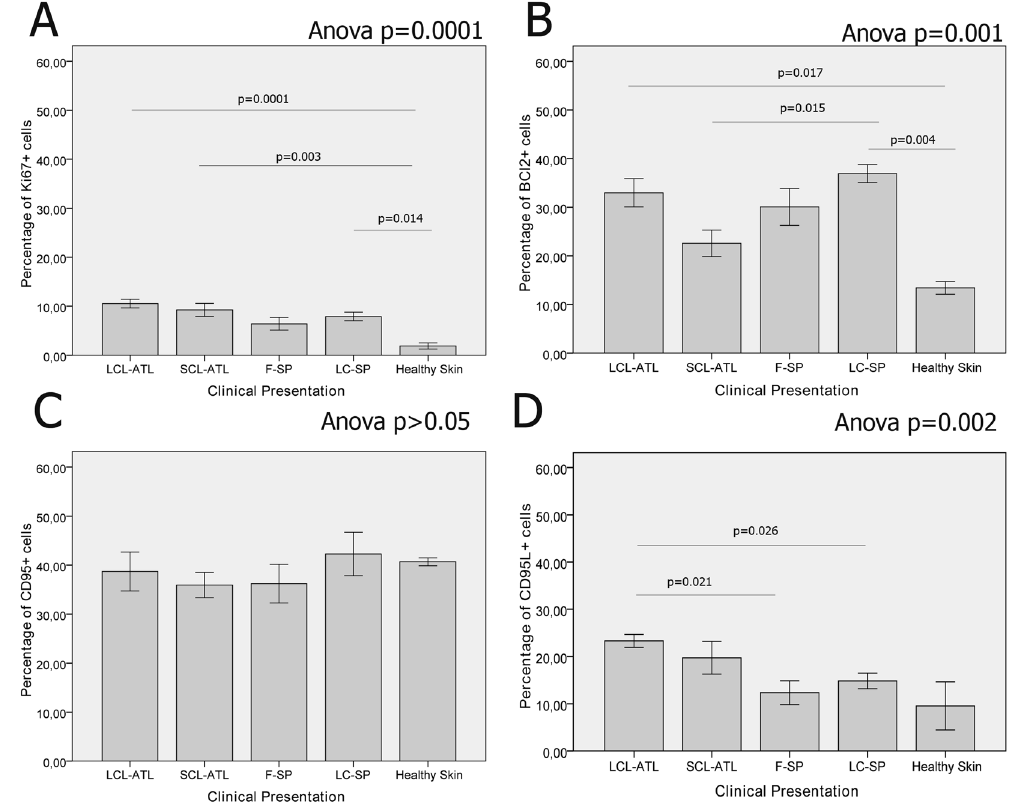
Figure 4. Percentage of ( A ) Ki67 + , ( B ) BCl2 + , ( C ) CD95 + (Fas + cells), ( D ) CD95L + (FasL + cells). Data represented as mean and SEM. P-value < 0.05 was considered statistically significant. LCL-ATL: localized cutaneous leishmaniasis; SCL-ATL: sporotrichoid cutaneous leishmaniasis; F-SP: fixed sporotrichosis; LC- SP: Lymphocutaneous sporotrichosis. Anova test was used for variables with normal distribution, otherw ise Kruskal-Wallis test was applied. Bonferroni test was used as post hoc